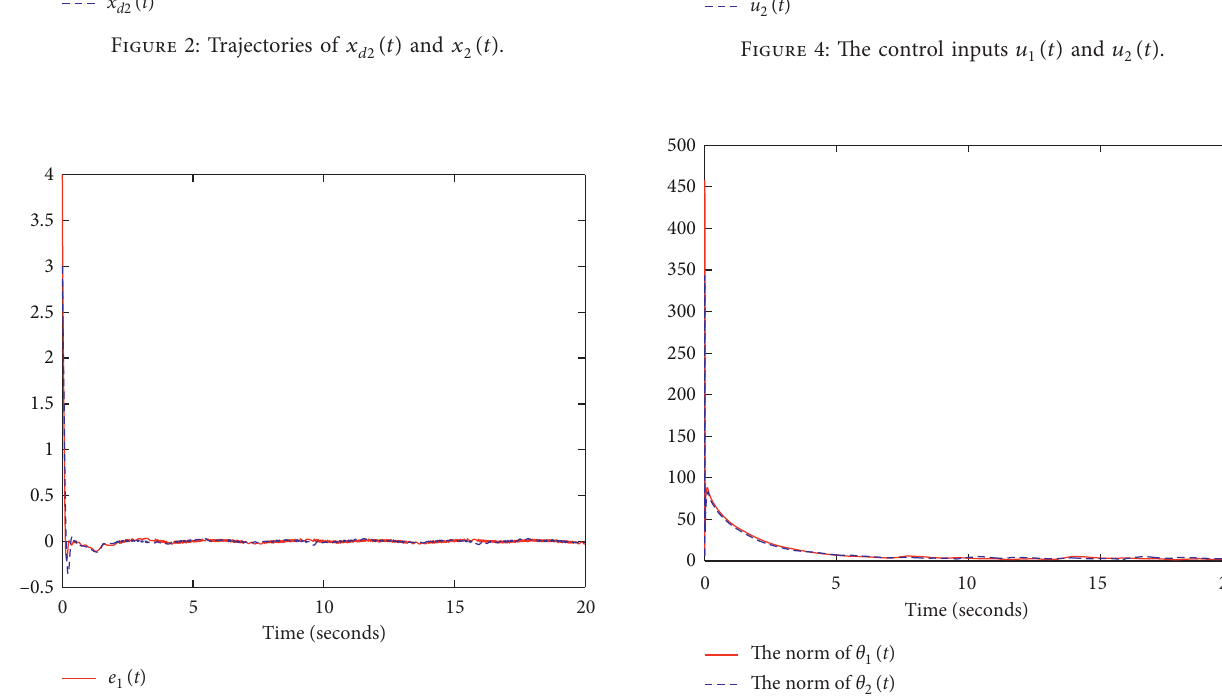
Figure 2: Trajectories of x